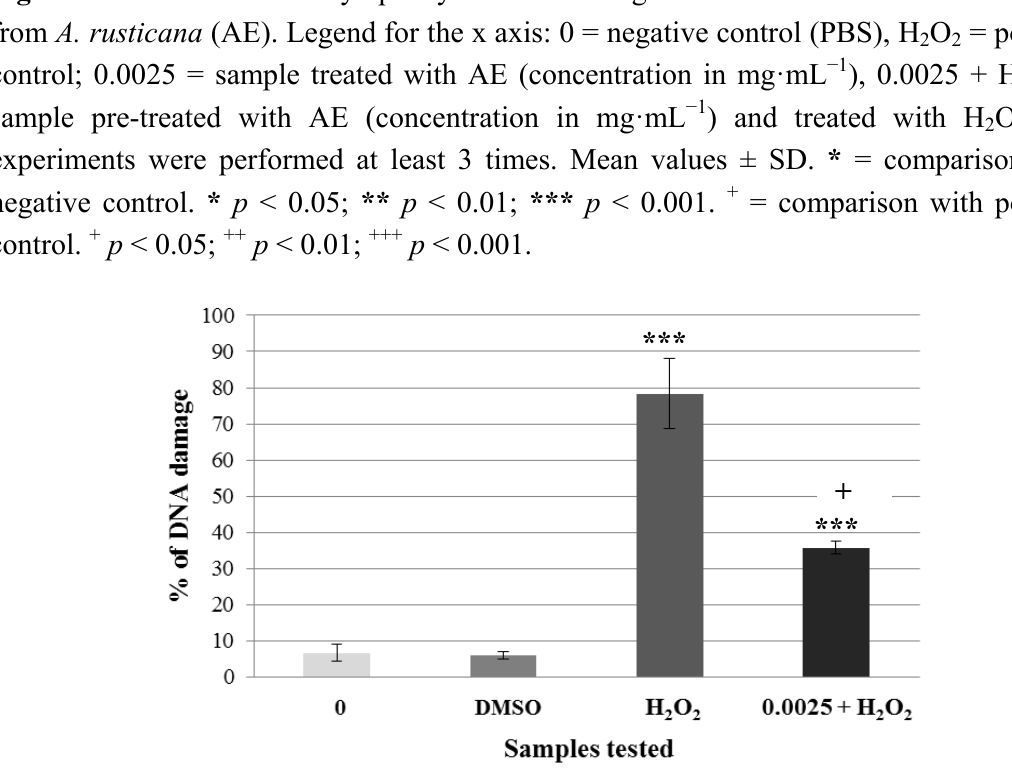
Figure 4. Pre-incubation of lymphocytes with a non-genotoxic concentration of the